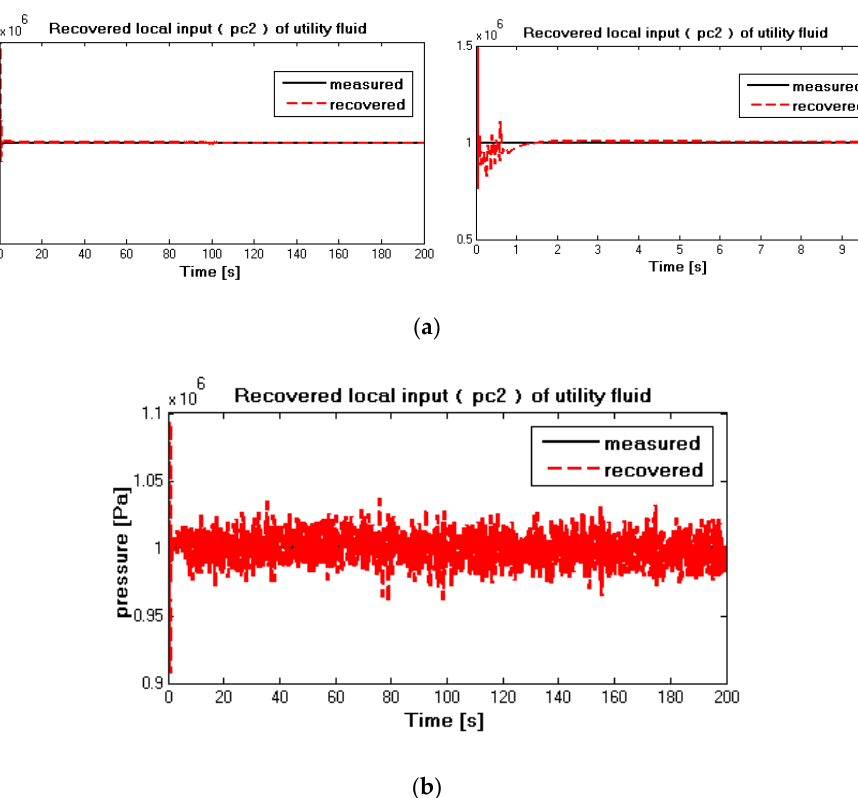
Figure 9. ( a ) Measured and recovered p c 2 (noise-free situation) in case 1; ( b ) measured and recovered p c 2 (noise-corrupted situation) in case